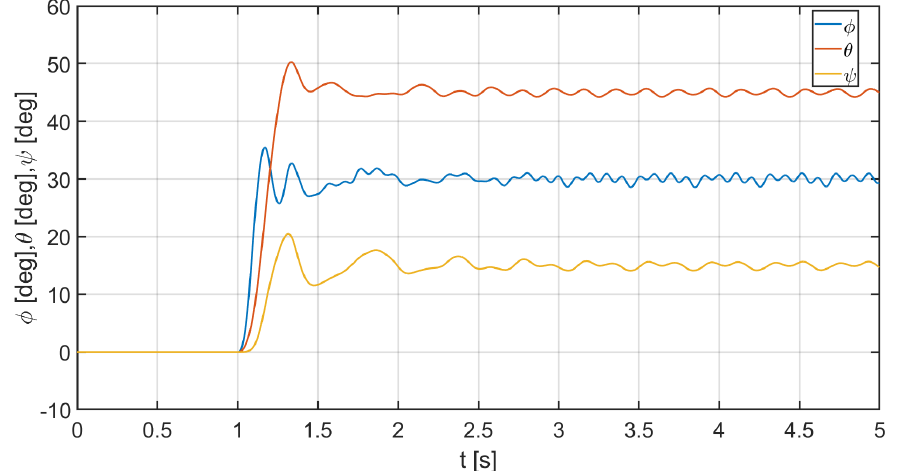
Figure 3. UAV angular response—PID control